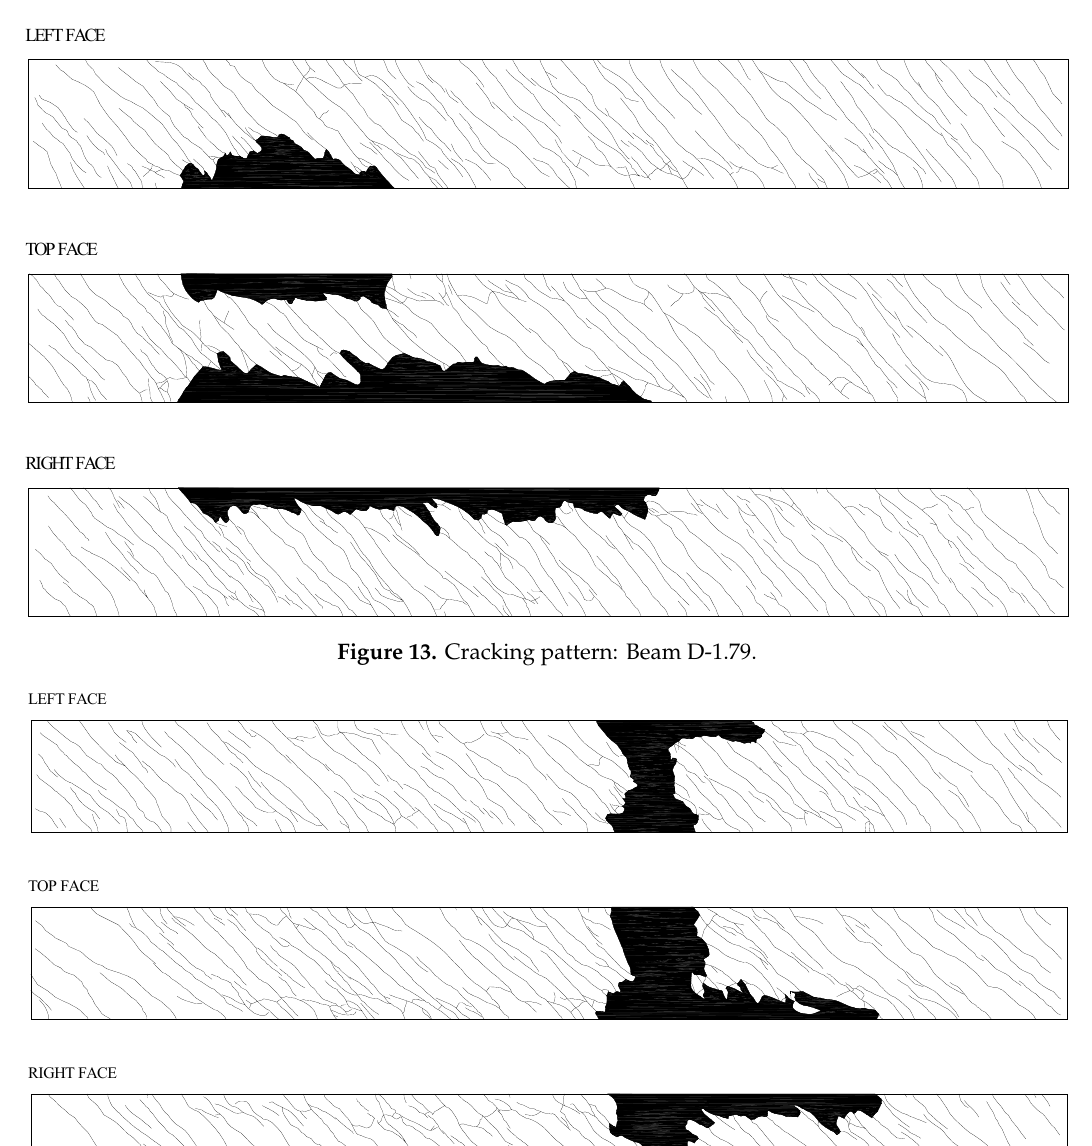
Figure 12. Cracking pattern: Beam D-0.